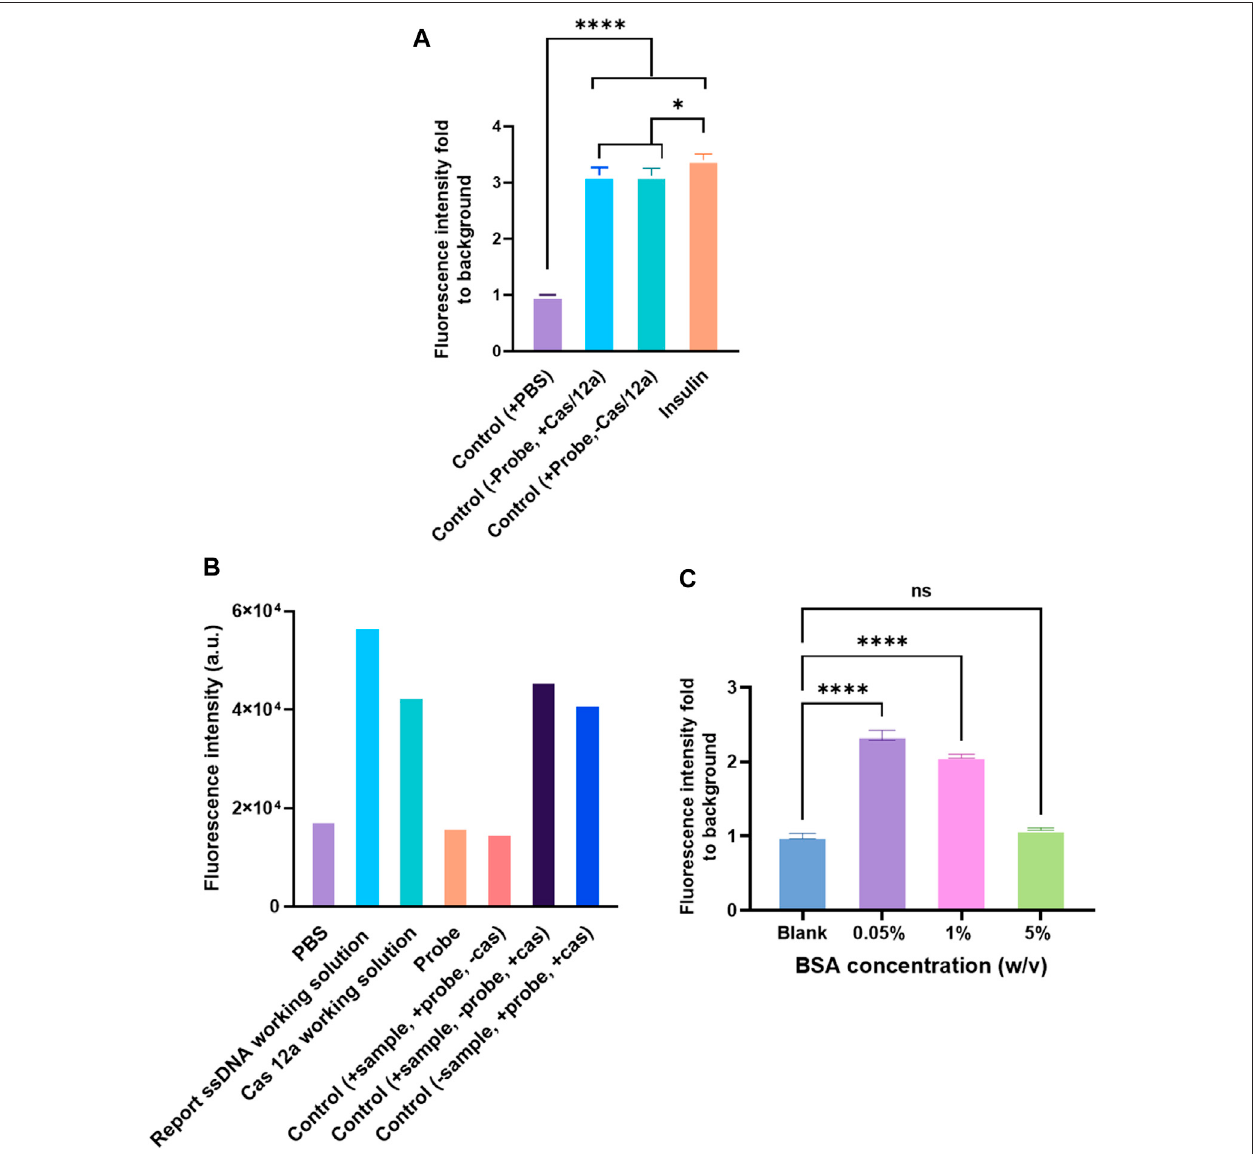
FIGURE 3 | Factors affecting the assay performance. (A) Detection of human insulin (1 ng/ml) by CRISPR/Cas12a-assisted new immunoassay (CANi). The polystyrenesurfacewascoatedwith10 μ g/mlstreptavidin fi rst,andthenthebiotinylatedcaptureantibody(ab53591,Abcam)wasimmobilizedonthesurfacebybinding tostreptavidin. (B) Backgroundsignalanalysis.Theprobewasfabricated withabiotinylatedpolyclonalantibody. (C) Blockingsolutionoptimization.Selectionofcapture and detection antibody pair.